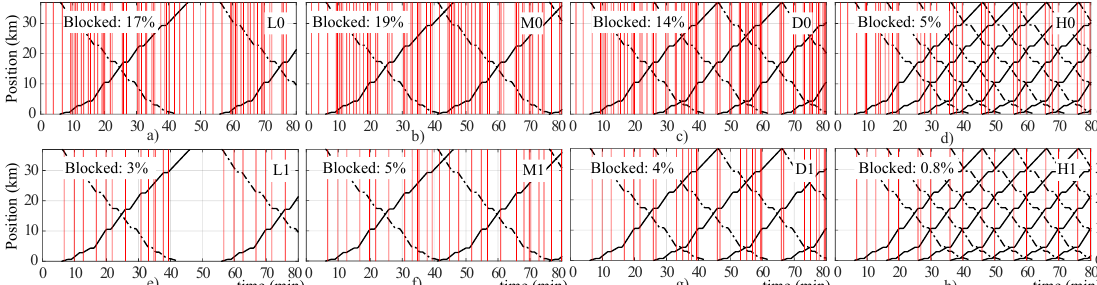
Figure 8. Marey diagrams representing the first 80 min of the schedule of the red line in the different scenarios. Solid lines represent the trains moving from S1 to S6, while dashed-dotted lines represent the trains moving from S6 to S1. The vertical red lines mark the instants at which all the substations in the system were blocked due to the high regenerated power surplus. The number in the top-left corner of each subfigure represents the percentage of instants at which all the substations were blocked at the same time for the whole simulation interval. The scenario is indicated in the top-right corner of each subfigure. ( a ) Light Traffic without accumulation; ( b ) Medium traffic without accumulation; ( c ) Dense traffic without accumulation; ( d ) Heavy traffic without accumulation; ( e ) Light Traffic with accumulation; ( f ) Medium traffic with accumulation; ( g ) Dense traffic with accumulation; ( h ) Heavy traffic with